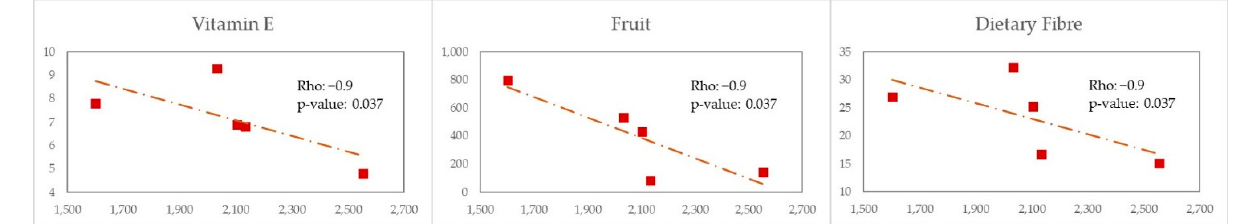
Figure 10. Scatter plot X—Erysipelotrichaceae, Y—Nutrients/Food for MSM-WEL.